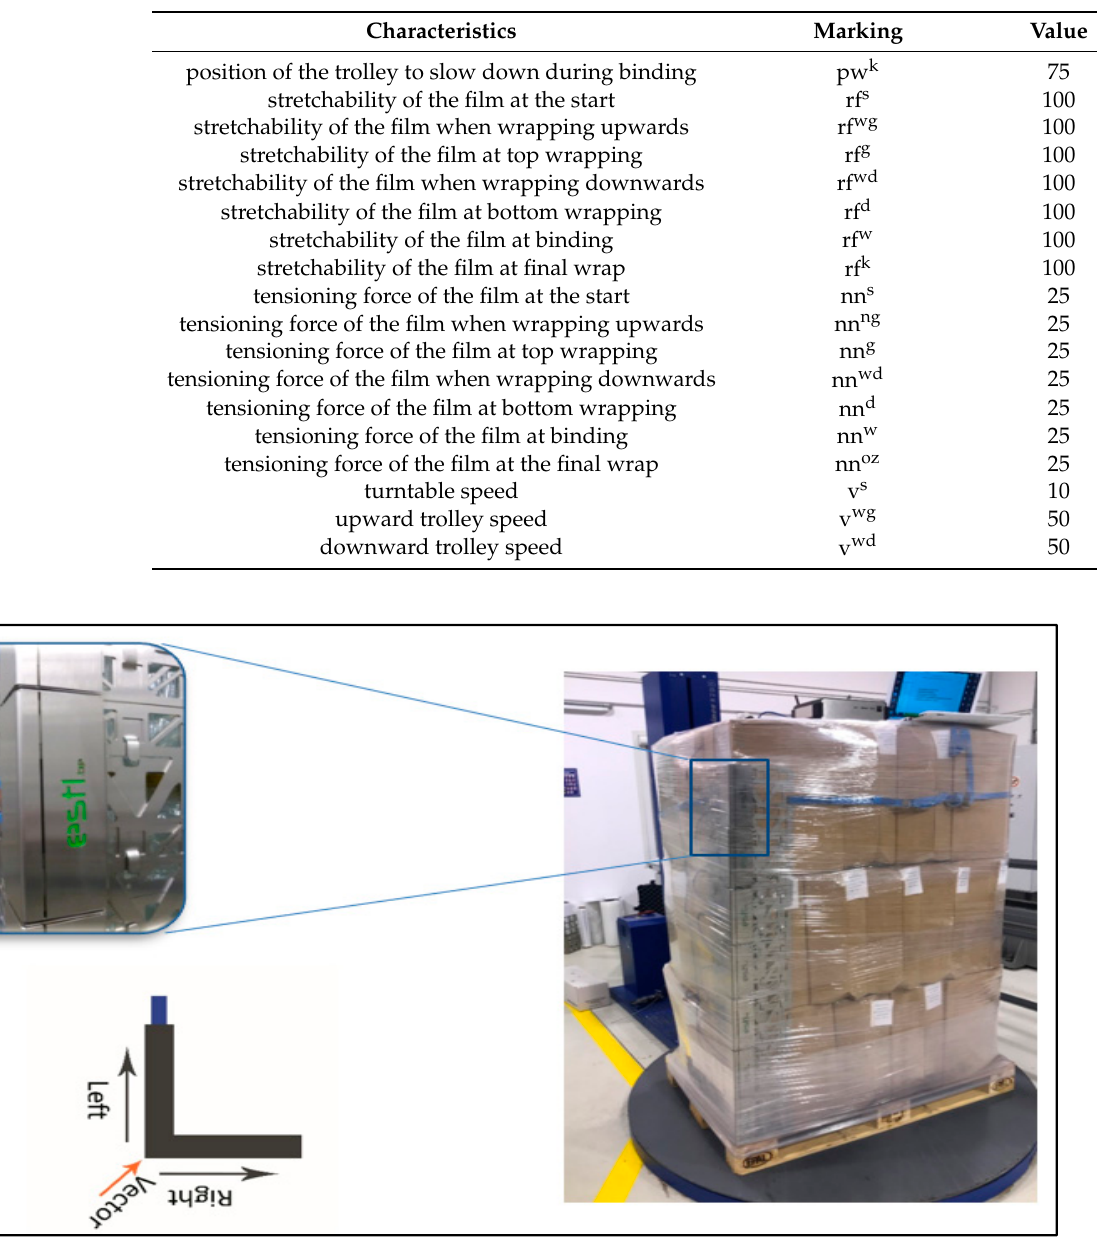
Figure 7. Cargo stabilization forces with the application of the standard film.